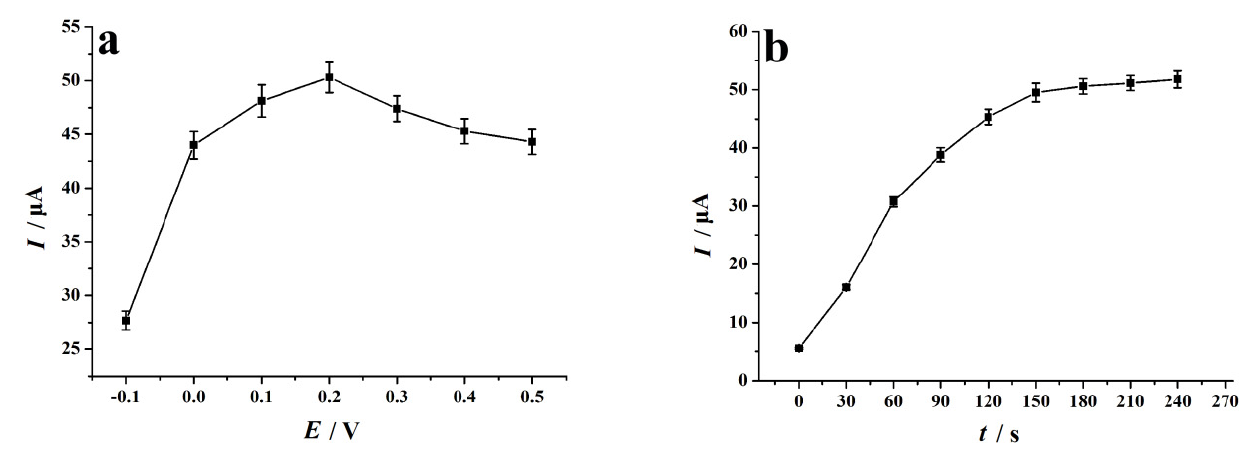
Figure 6. ( a ) Effect of accumulation potential on the peak current of 0.1 mM 4-NP after 150 s accu- mulation time; ( b ) effect of accumulation time on the peak current of 0.1 mM 4-NP at the accumu- lation potential of 0.2 V. Supporting electrolyte: 0.2 M H 2 SO 4 solution, scan rate: 0.1 V s − 1 , error bars represent SD, n = 3.